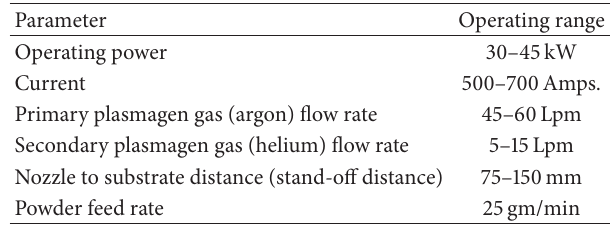
Table 1: Selected operating parameters for plasma spray coating